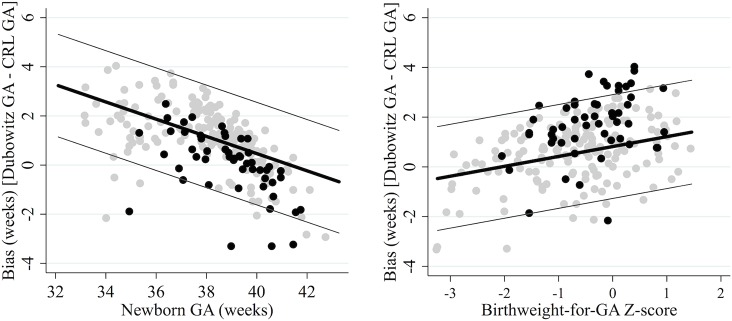
Agreement between CRL biometry and the Dubowitz method.GA: gestational age. Reference standard: crown-rump length (CRL) biometry. True gestational age determined from CRL biometry. The thick black lines represent the mean bias of the Dubowitz method in reference to CRL biometry; the thin grey lines represent the 95% limits of agreement. Grey dots are observed values for newborns with normal birthweight for GA (left) or term newborns (right); black dots are observed values for SGA newborns (left) or preterm newborns (right).